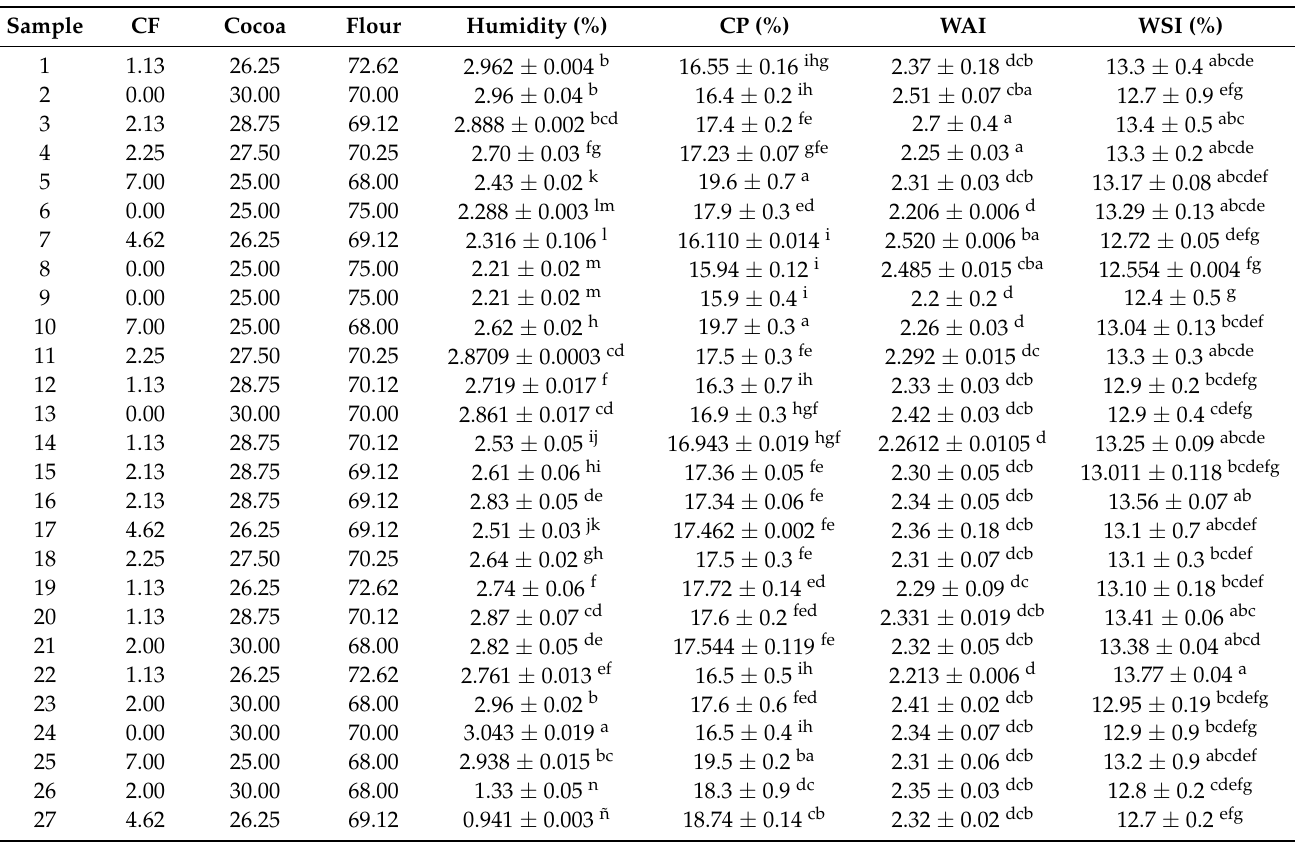
Table 1. Percentage (%) of cricket flour (CF), cocoa and flour used in chuculas. Mean values ± standard deviation of the % of humidity, crude protein (CP), absorption index (WAI) and solubility index (WSI) of each sample. Superscript letters within columns indicate homogeneous groups according to ANOVA ( p <